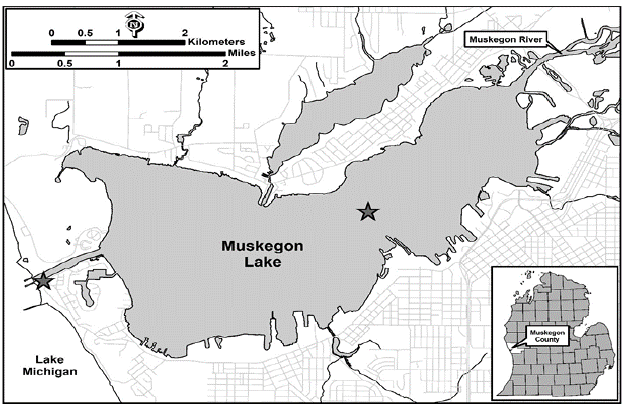
Figure 1. Locations (channel and lake) for Deployment (filled stars) of Microplastics in Muskegon Lake.